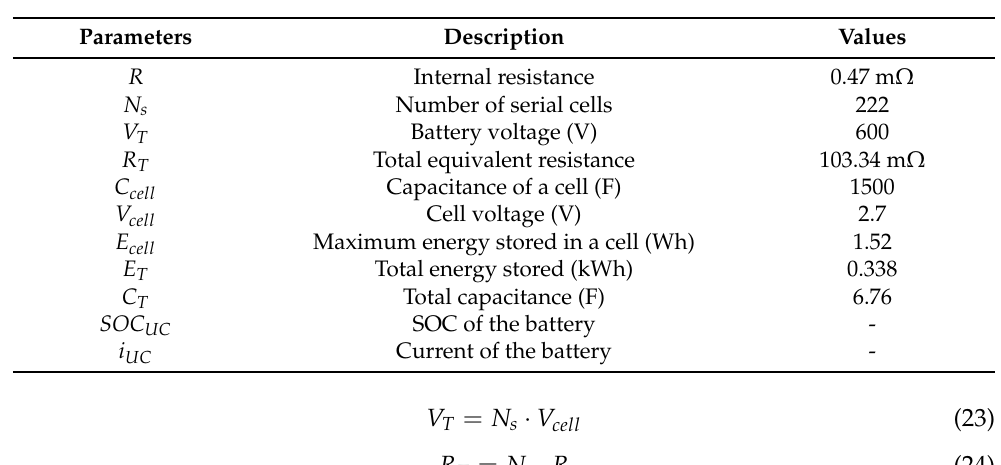
Table 4. Ultracapacitor parameters.